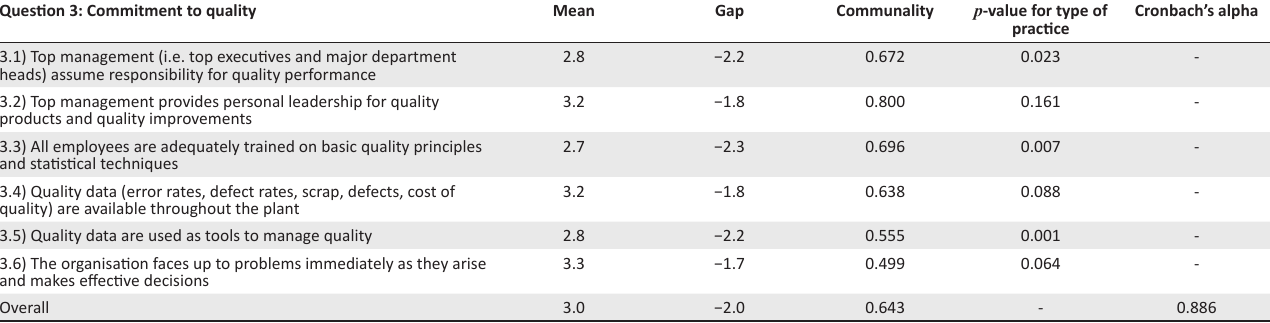
TABLE 4: Results pertaining to commitment to quality. Question 3: Commitment to quality